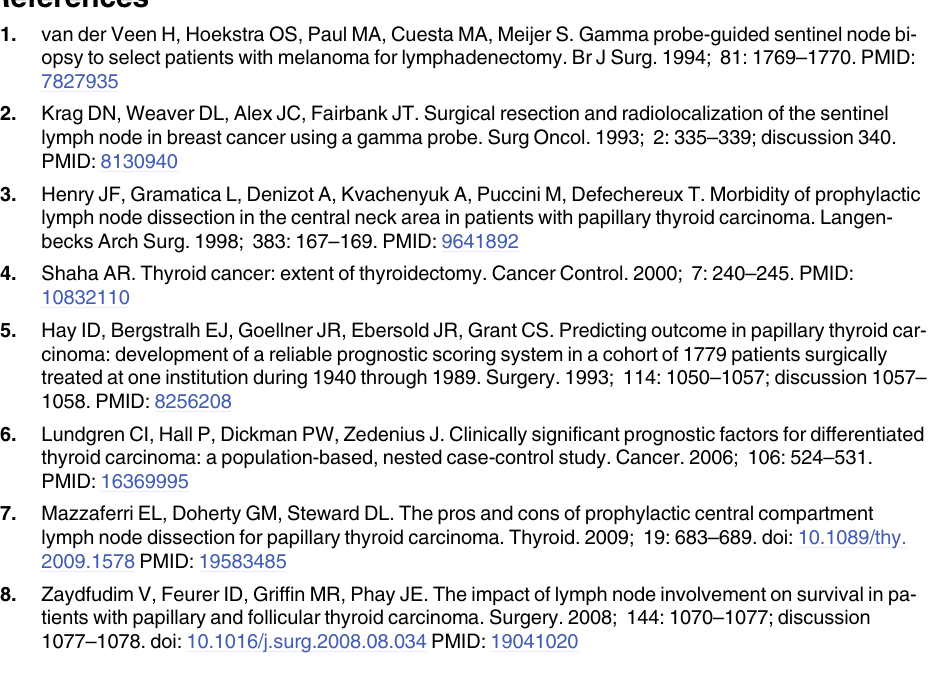
S1 Table. Original data for study